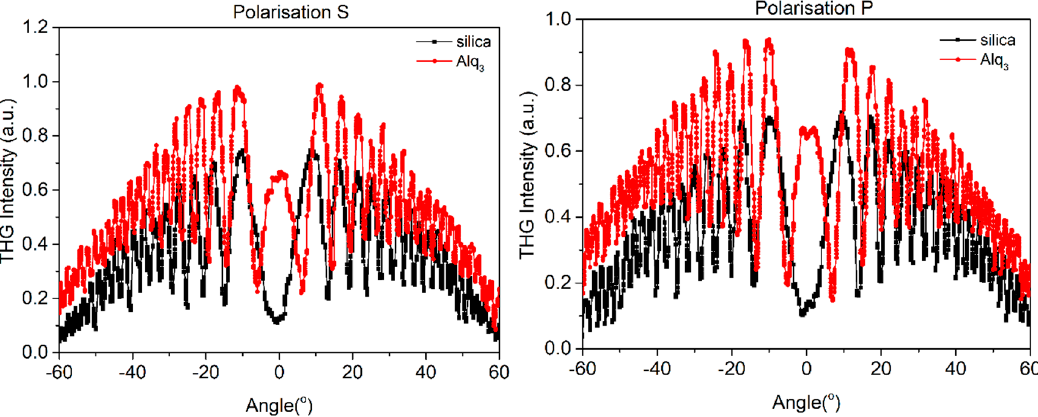
Figure 7. Third harmonic intensity of Alq 3 film and silica as a function of the incident angle for polarization s and p. Table 1. The values of the third order nonlinear optical susceptibility 𝝌 𝑻𝑯𝑮(𝟑) of thin films obtained from the third harmonic generation (THG) technique for polarization s and p.